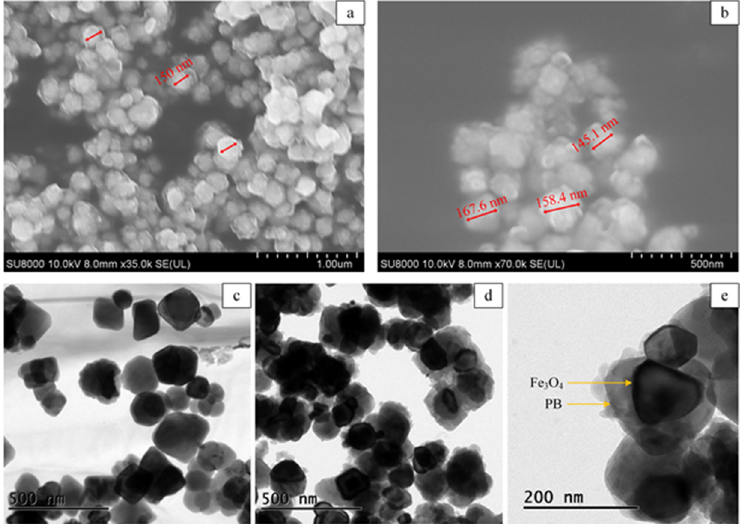
Figure 1. ( a , b ) Scanning electron microscope (SEM) images of the Fe 3 O 4 @PB; transmission electron microscopy (TEM) images of ( c ) Fe 3 O 4 and ( d , e ) Fe 3 O 4 @PB nanoparticles.